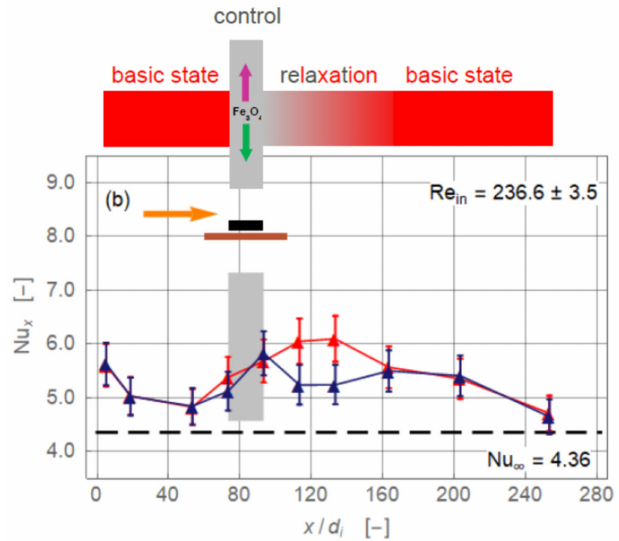
Figure 9. Characteristic of flow control. Magnet below pipe ( a ) and magnet above pipe ( b ). Symbols as in Figure 4. Green arrow acting on the Fe 3 O 4 nanoparticle represents gravity and purple arrow, magnetic force. The red areas above the plots indicate the zones of the base state. Grey areas show regions where the magnets affect the flow and therewith the local heat transfer. The grey marked relaxation regions stretch well downstream from the rear ends of the